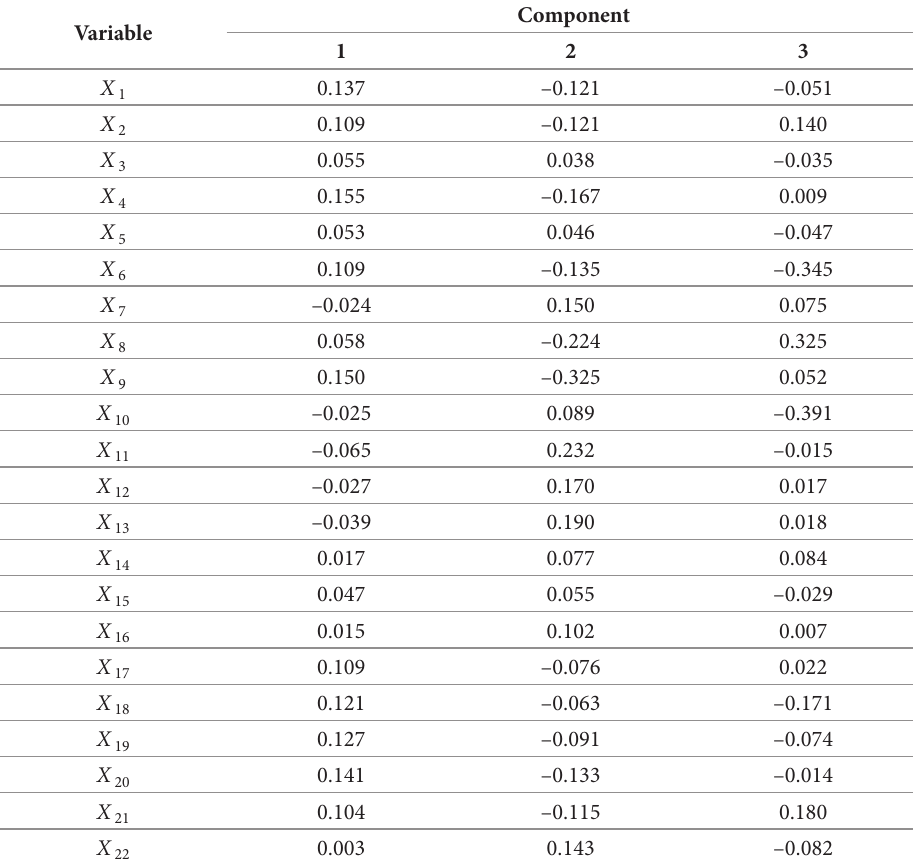
Table 6. Coefficient Matrix of Component Scores